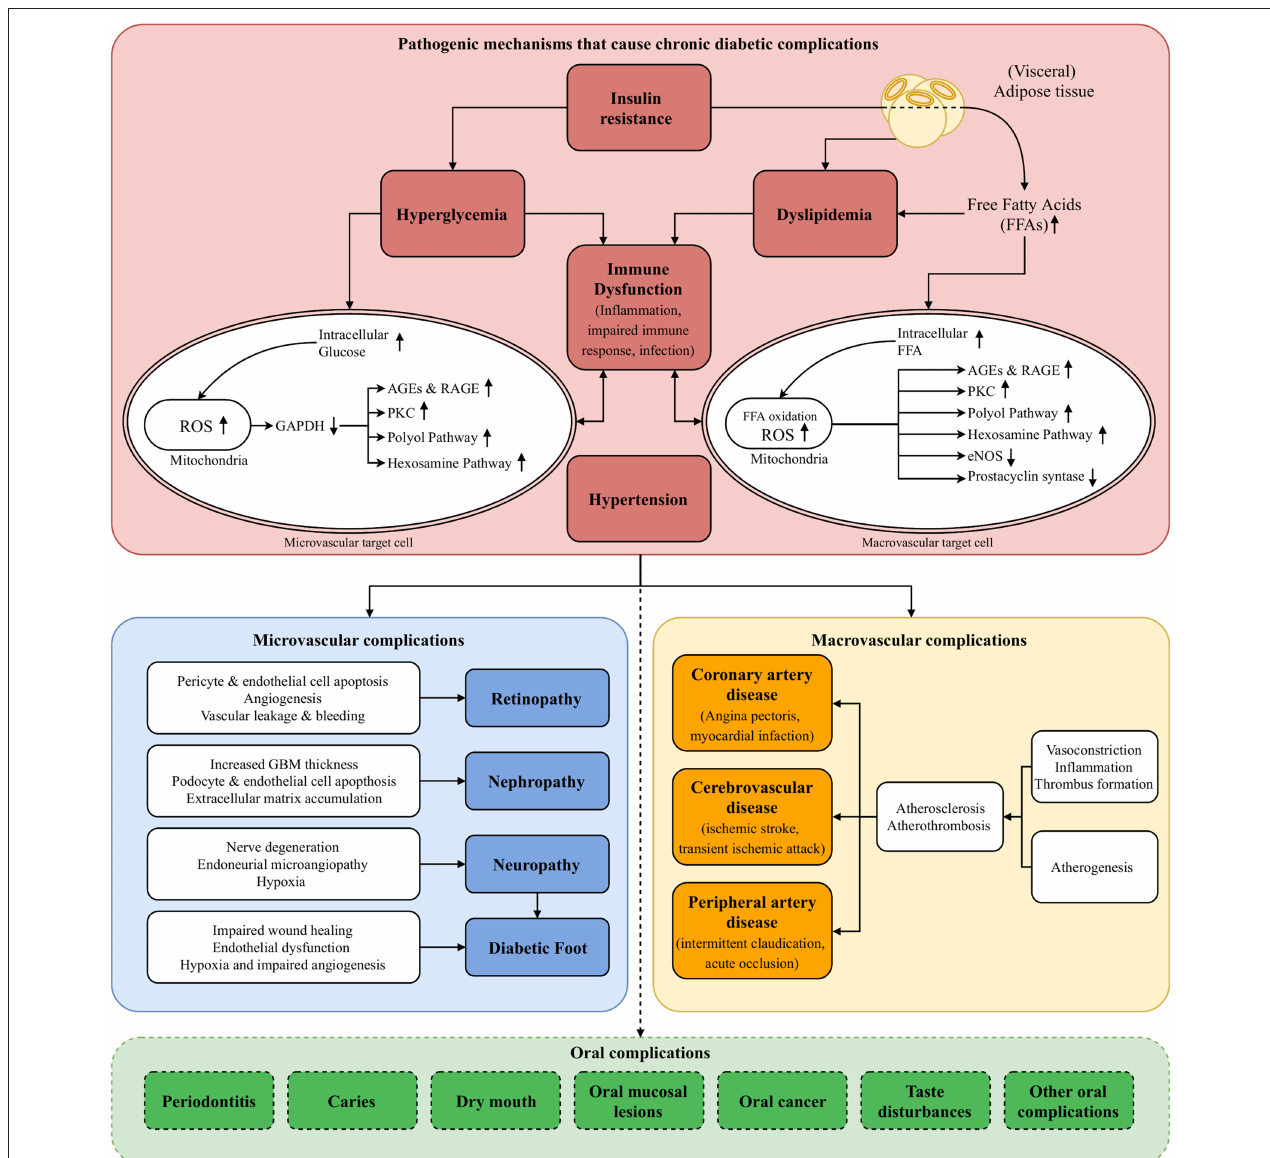
FIGURE 1 | Pathogenesis of diabetic complications. The figure presents the pathogenic mechanisms of diabetes mellitus (DM; red block, section Pathogenic Mechanisms of Diabetic Complications of main text) that cause microvascular complications (blue block) and macrovascular complications (yellow block). Destruction of pancreatic B cells in T1DM and insulin resistance in T2DM result in hyperglycemia. The resulting increase of intracellular glucose in microvascular target cells, such as capillary endothelial cells, causes ROS production in the mitochondria, activating four pathogenic downstream pathways: polyol pathway, AGEs & RAGE pathway, PKC pathway, hexosamine pathway (section Hyperglycemia of main text). Especially in T2DM, insulin resistance and the abundance of (visceral) adipose tissue result in an excess flux of free fatty acids (FFAs), which are oxidized in the mitochondria of macrovascular endothelial cells. This causes activation of the same pathogenic pathways, and downregulation of protective enzymes such as eNOS and prostacyclin synthase. Pathway-selective insulin resistance also contributes to microvascular complications (section Insulin Resistance of main text). Moreover, insulin resistance and circulating FFAs result in dyslipidemia, contributing to both micro- and macrovascular complications (section Dyslipidemia of main text). Hypertension contributes to the harmful processes by activating endothelial cells, inducing a cellular inflammatory response and reducing the availability of nitric oxide, causing vasoconstriction (section Hypertension of main text). All these processes mainly exert their harmful effects by upregulation of a pro-inflammatory state at vulnerable sites. Together with an impaired immune response and consequently higher susceptibility for infections, this immune dysfunction plays a pivotal role in the development of diabetic complications (section Immune Dysfunction of main text). Possible oral complications that are discussed in this review are listed in the green block at the bottom of the figure (section Potential Oral Complications of Diabetes Mellitus of main text). eNOS, endothelial Nitric Oxide Synthase; FFAs, Free Fatty Acids; GAPDH, Glyceraldehyde 3-phosphate Dehydrogenase; GBM, Glomerular Basement Membrane; PKC, Protein Kinase C; (R)AGEs, (Receptor for) Advanced Glycation End products; ROS, Reactive Oxygen Species.